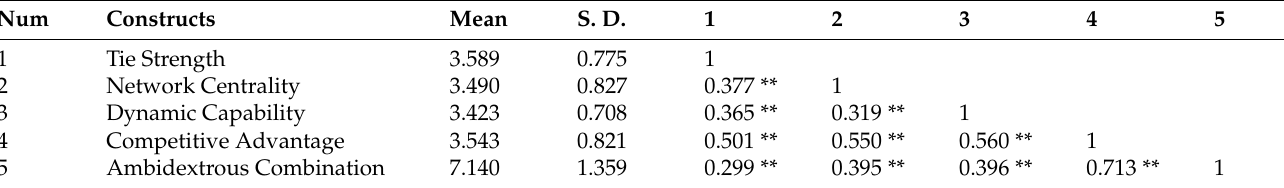
Table 2. Mean, standard deviation and Pearson’s r.